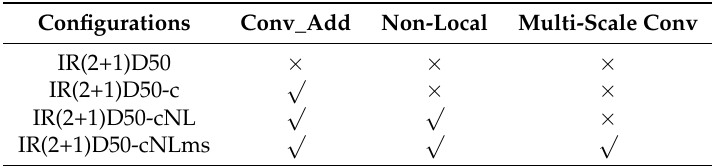
Table 5. Different configurations of models.